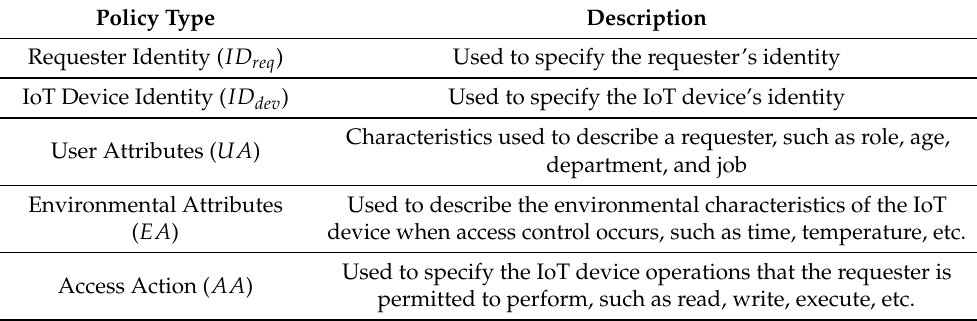
Table 2. Common Access Control